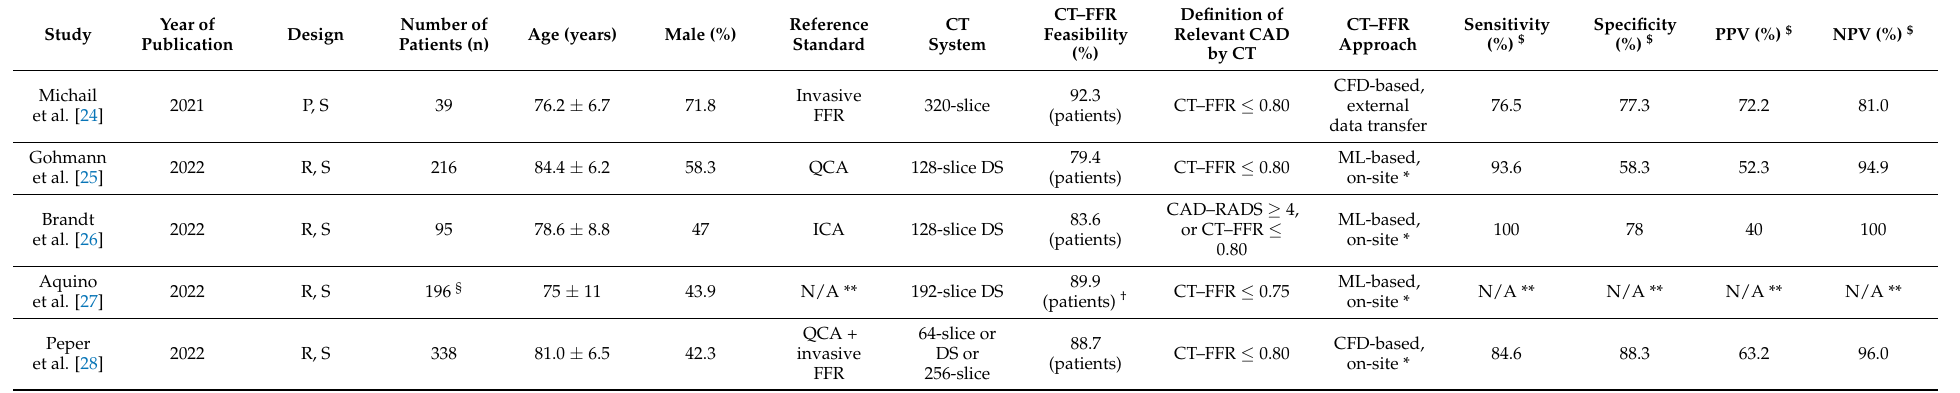
Table 2. Relevant studies focusing on the diagnostic performance of preprocedural CT–FFR before TAVI for the detection of relevant